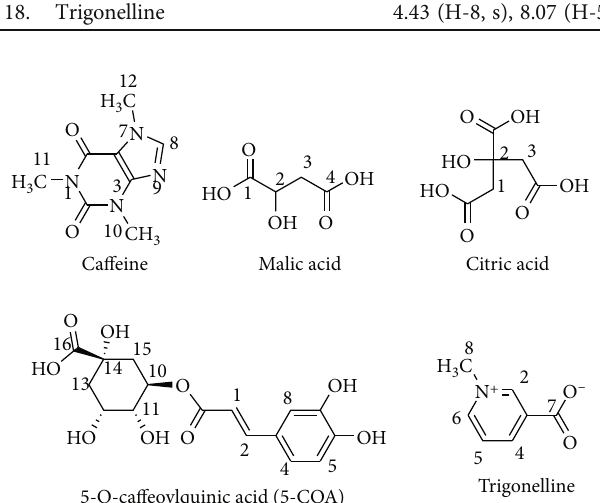
Figure 2: Some molecular structures of the identi fi ed compounds in the green co ff ee